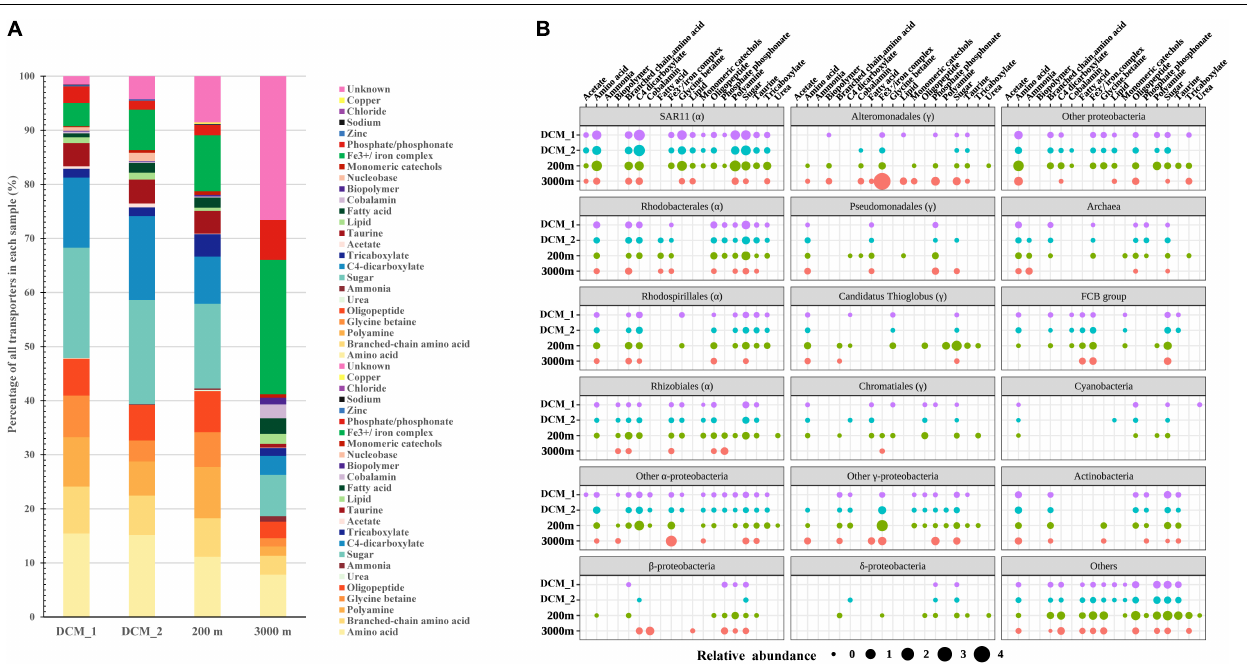
FIGURE 4 | Distribution of transporters in the vertical exoproteomes from the SCS. (A) Transporter profiles classified by their predicted substrates. Data are represented as percentage of total relative abundance of transporters detected in each sample. (B) Vertical profiles of transporters from different taxa. Bubble size indicates the relative abundance of transporters summed by